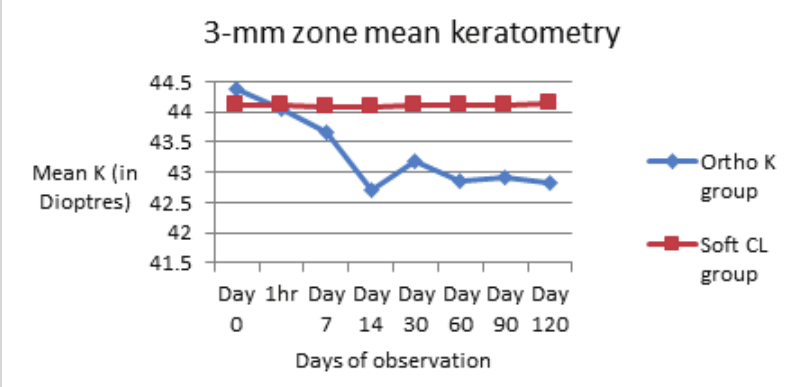
Figure 3. Change in mean keratometry in both groups in 3-mm zone. CL, contact lens; K, keratometry; Ortho K, Orthokeratology.